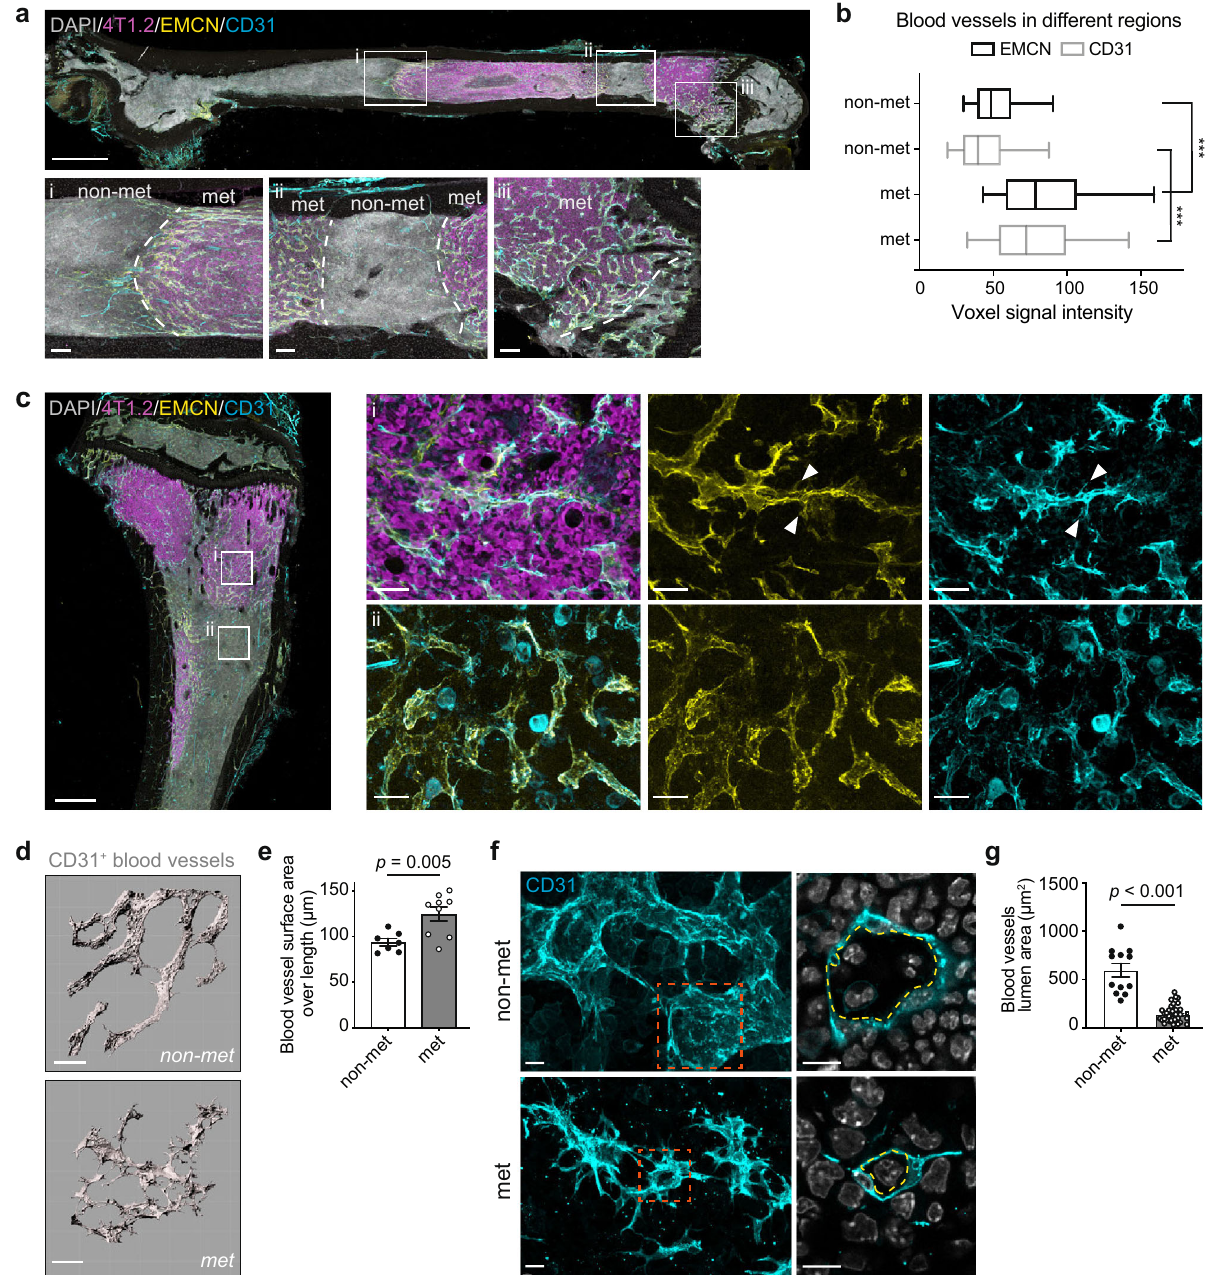
Fig. 3 Metastatic mammary cancer cells remodel the bone marrow vasculature upon expansion. a Tile scan (top) and enlarged (bottom) 3D images of femoral BM stained for DAPI (grey), 4T1.2 cells (magenta), EMCN (yellow) and CD31 (cyan) reveal vessel remodelling in tumour-in fi ltrated area (met) but not in the adjacent tumour-free area (non-met) ( n = 5 mice). Scale bars, 1 mm (top), 100 µ m (bottom). b Box and whisker plots of mean vascular CD31 and EMCN voxel intensity of individual vessels in non-met and met areas from n = 5 mice. Centre line; median; box limits, from the 25th to 75th percentiles; whiskers, from the 5th to 95th percentiles. *** P < 0.0001 by two-tailed unpaired t test. c Left: 3D image of femoral BM stained for DAPI (grey), 4T1.2 cells (magenta), EMCN (yellow) and CD31 (cyan). Right: zoomed-in images of met and non-met area (corresponding to (i) and (ii) from the left panel, respectively) ( n = 7 mice). Arrowheads indicate EMCN + CD31 + vascular sprouts. Scale bars: 500 µ m (overview), 50 µ m (enlargement). d Digital reconstructions of CD31-positive blood vessels in non-met and met areas. Scale bar, 50 µ m. e Measurements of endothelial surface area over vessel length from ( d ). n = 7 (non-met) and 9 mice (met). P value, two-tailed unpaired t tests. f 3D images of CD31-positive blood vessels (cyan) in non-met and met area. Right panel shows optical section from the selected area in left panel. Yellow lines demarcate vessel lumen. Scale bars: 20 µ m. g Lumen area from ( f ). Individual dots are from one vessel. n = 5 (non-met) and 10 mice (met). P value, two-tailed unpaired t tests. All data re fl ect mean ± s.e.m. Source data are provided as a Source Data fi